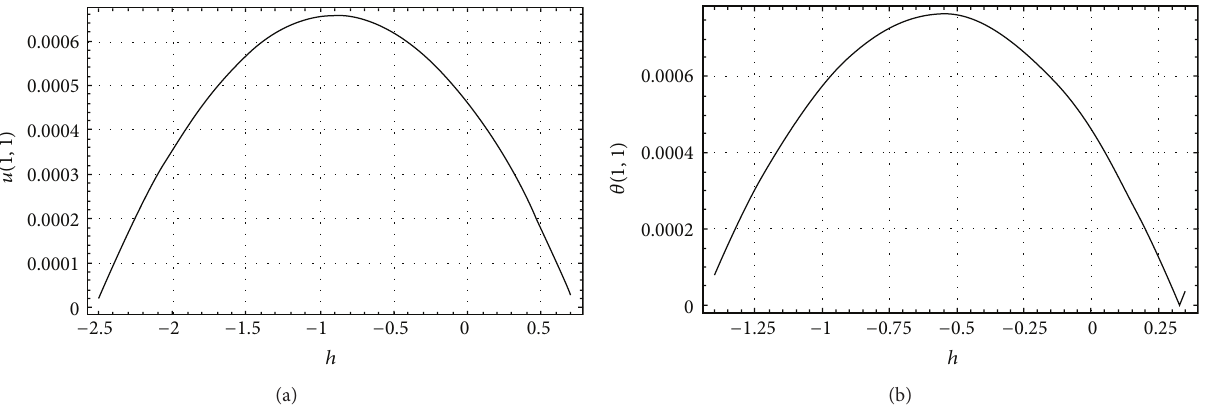
Figure 2: The ℎ -curve of the third-order approximate solutions of (14) when 𝑥 = 1.0 , 𝑡 = 1.0 ; for GL model when 𝜏 2 = 0.2 , 𝜏 1 = 0.1 , 𝛿 = 0 , = 0.2 , 𝜎 = 0.1 , Ω = 0.1 , and 𝜔 = 0.02 . 𝜎 1 2